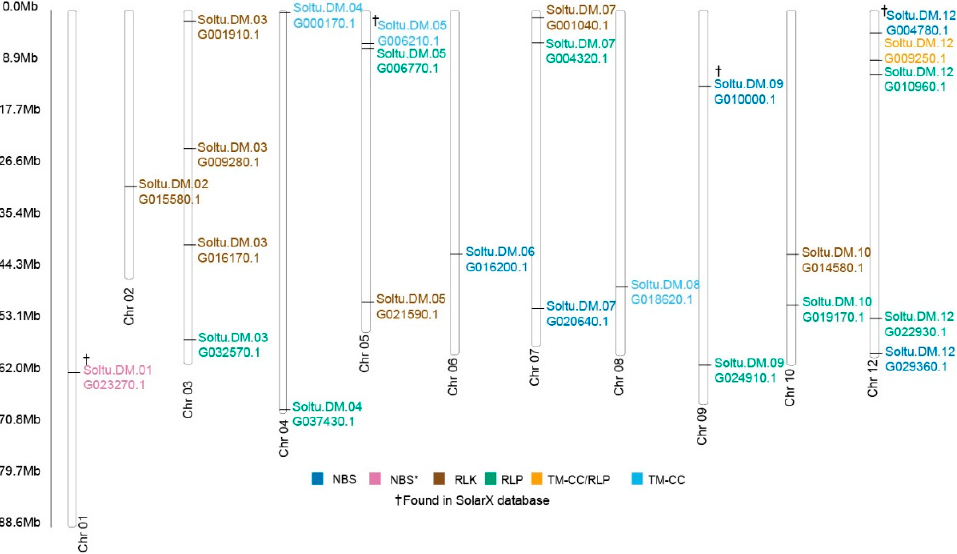
Figure 6. Distribution of the PVX-upregulated PRG analogs along S. tuberosum chromosomes. The scale indicates the genome size of S. tuberosum in Mb. Genes are color-coded according to the legend in the figure. “†” genes in the SolariX database search.